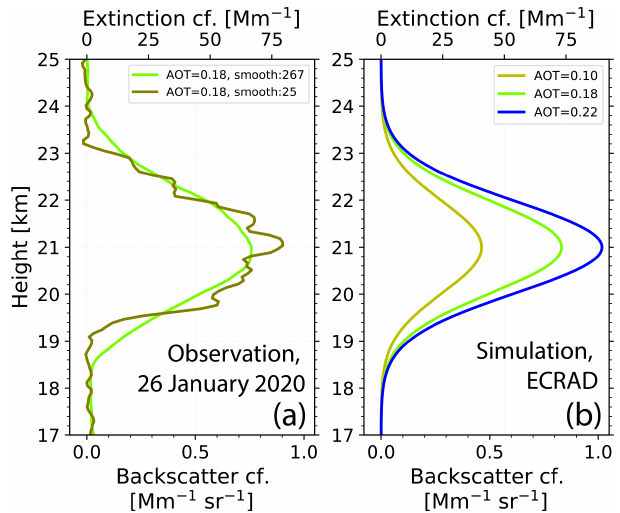
Figure 3. (a) The 532nm particle backscatter coefficient of a wild- fire smoke layer between 19 and 23km height. The smoke plume was measured with ground-based lidar at Punta Arenas on 26 Jan- uary 2020, 04:27–06:18UTC (Ohneiser et al., 2022). The verti- cal signal-smoothing length is 187.5m (25 bins, olive profile) and 2002.5m (267 bins, green profile). The extinction coefficient is ob- tained by multiplying the smoke backscatter coefficients with a lidar ratio of 91sr (Ohneiser et al., 2022). The smoke layer optical thick- ness is 0.18. (b) Parameterized backscatter and extinction profiles (Gaussian shape) with adjustable layer center and layer thickness, here for AOT = 0.10, 0.18, and 0.22. The parameterized profiles are used as input in the heating rate simulations.